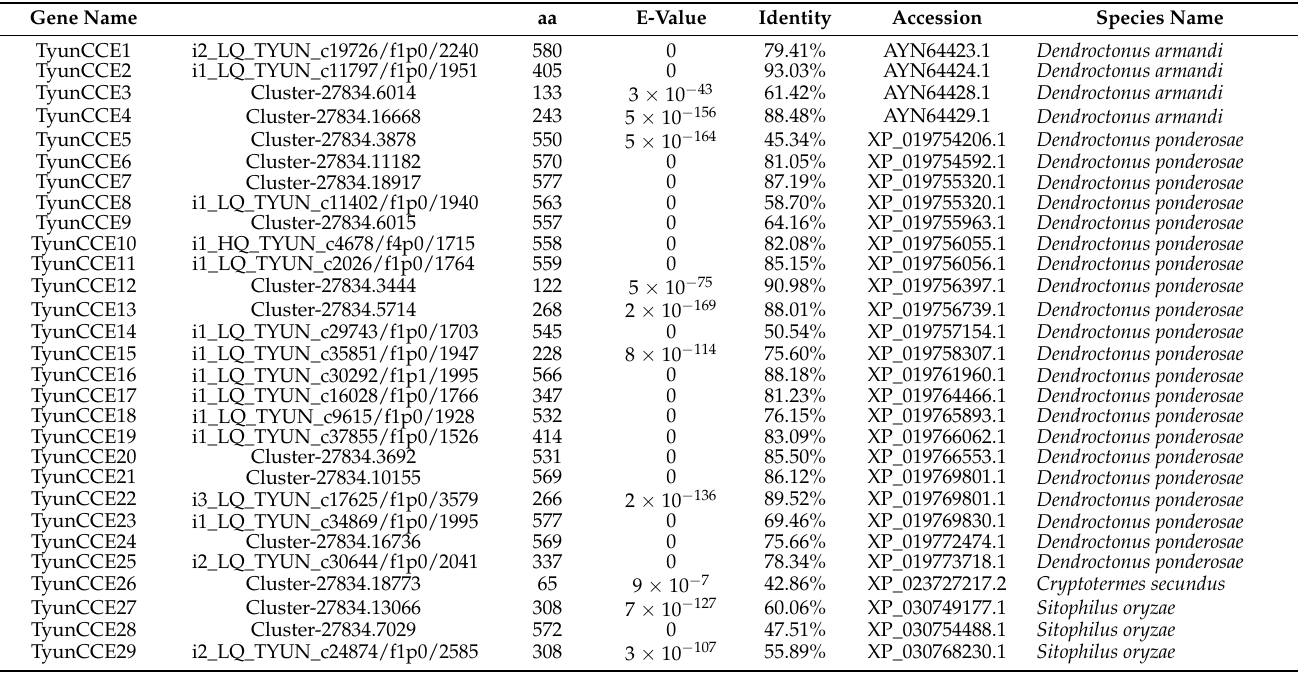
Figure 4. Neighbor ‐ joining tree of candidate GSTs. Bootstrap values after 1000 replications. Dpon, Dendroctonus ponderosae ; Darm, Dendroctonus armandi ; Agla, Anoplophora glabripennis ; Ldec Leptinotarsa decemlineata ; Tcas, Tribolium castaneum ; Tyun, Tomicus yunnanensis . Table 6. Best BLASTX matches of T. yunnanensis CCEs.